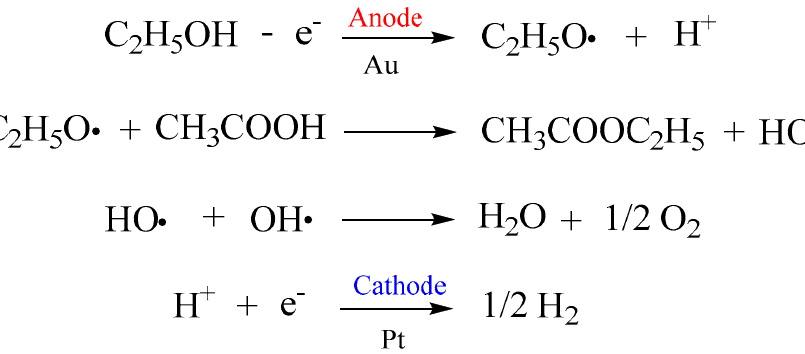
Figure 5. Schematic representation of the free radicals formed during the esterification process. To sum up, from the perspective of methodology, this study explored the thermody- namic and kinetic laws of esterification in Baijiu and proposes that a new method be applied to regulate its aroma intensity without adding foreign substances. From the